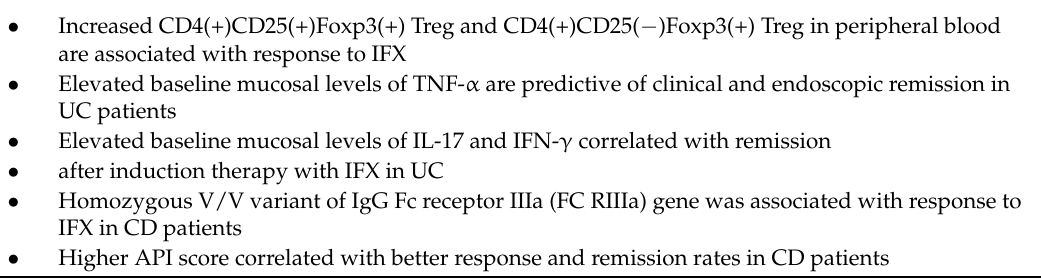
Table 3. Predictive factors of response to anti-TNF- α not yet available in clinical practice. Predictive